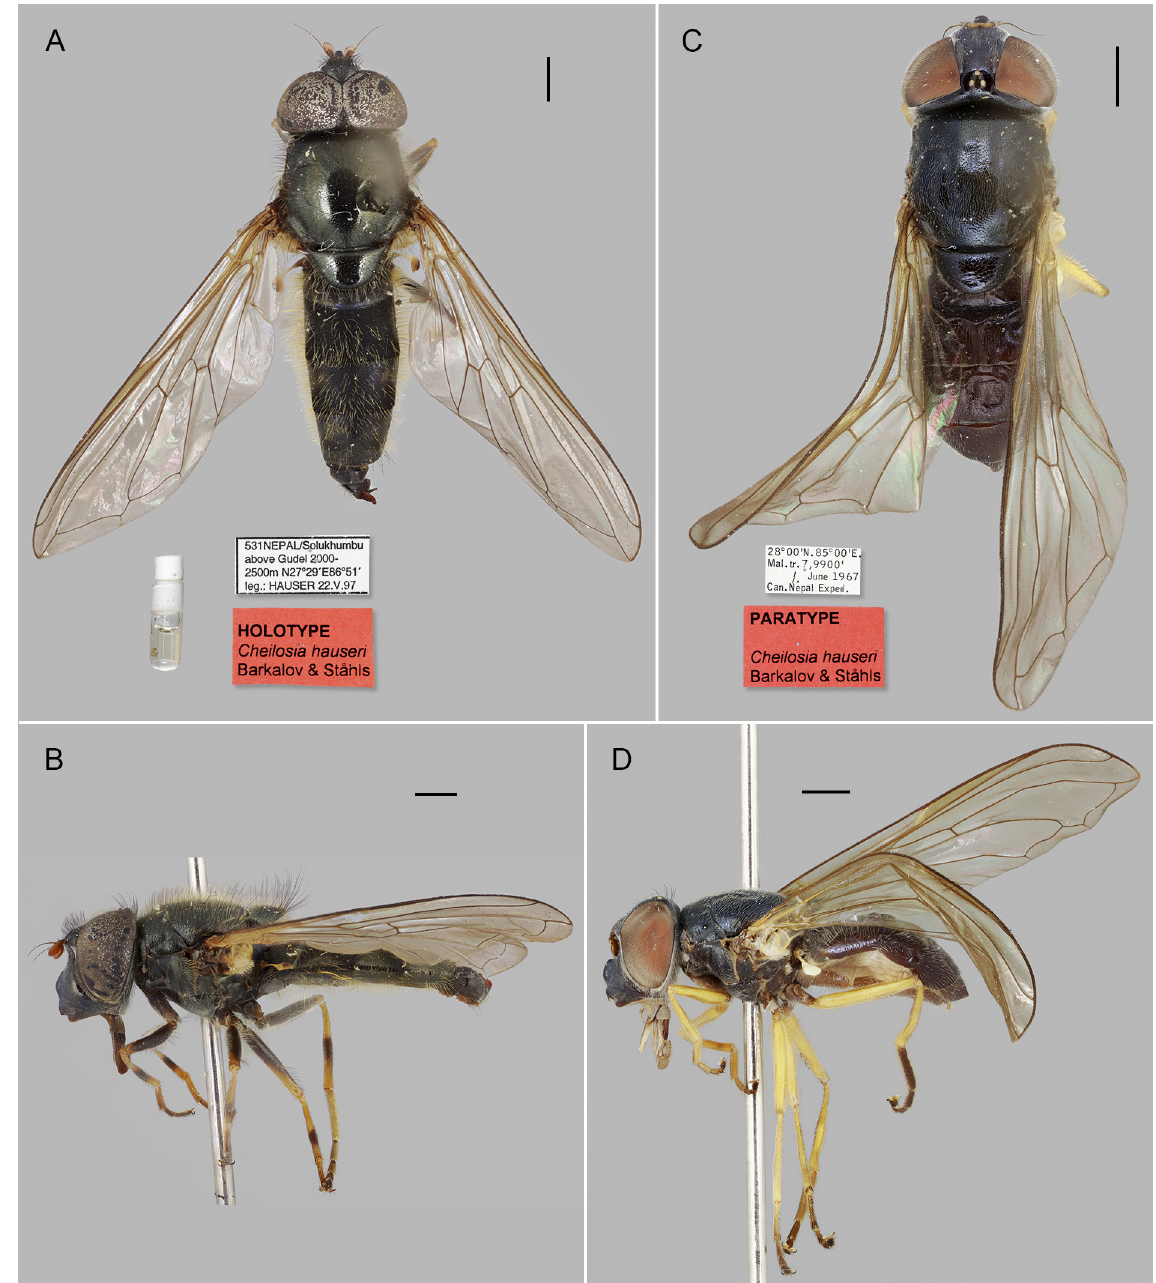
Fig. 28. Cheilosia ( Cheilosia ) hauseri sp. nov. A–B . Holotype, ♂ (CSCA); dorsal and lateral views. C–D . Paratype, ♀ (CNC); dorsal and lateral views. Photo: Pekka Malinen, FMNH Luomus. Scale bars = 1